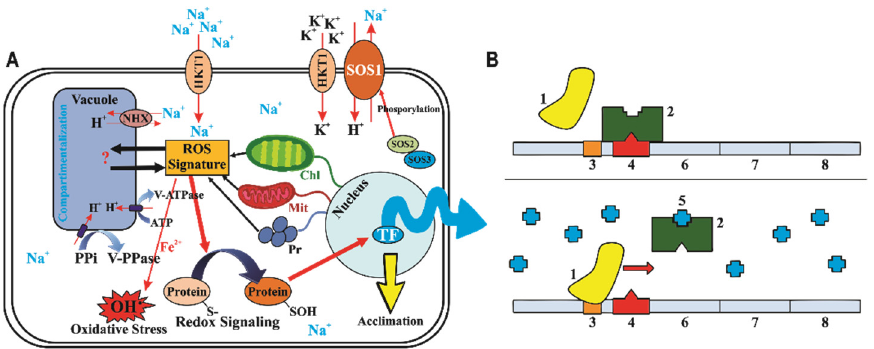
Figure 3. ( A ) The interaction between reactive oxygen species (ROS) produced from Na + signals. The ROS signature, promoted by an unknown pathway, compartmentalizes Na + into vacuoles. In the tonoplast, H + pumps equilibrate this compartmentalization. The ROS signature promotes the upregulation of a protein oxidation system that connects to the nucleus, promoting transcription factor (TF) activation and promoting some regulation of mitochondria (Mit), chloroplasts (Chl), and peroxisomes (Pr). In another way, the SOS1 channel in the plasma membrane promotes an antiporter flux of Na + and H + . Na+ and K+ compete with the same plasma membrane channel (HKT1). ( B ) Model proposed for the interaction between NaCl and catalase (CAT) gene expression. On non-salt-stressed plants (upper panel), the RNA polymerase (1) does not translate the CAT genes because there is a repressor (2) occupying the operon (4) on the CAT-encoding gene. Therefore, in salt-stressed plants (bottom panel), the H 2 O 2 (5) binds to repressor that remains inactive and then dissociates from the CAT-encoding gene. Afterwards, the RNA polymerase binds to promoter region (3) on the CAT-encoding gene and then promotes the translation of CAT1 (6), CAT2 (7), and CAT3 (8). Modified from the work of Choudhary, Rivero [85] and Muchate, Nikalje [79].